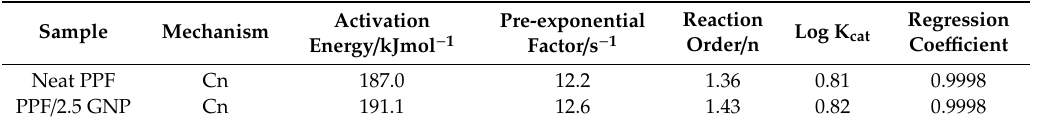
Table 2. Activation energy, pre-exponential factor and reaction order of neat PPF and PPF/2.5 GNP nanocomposite.